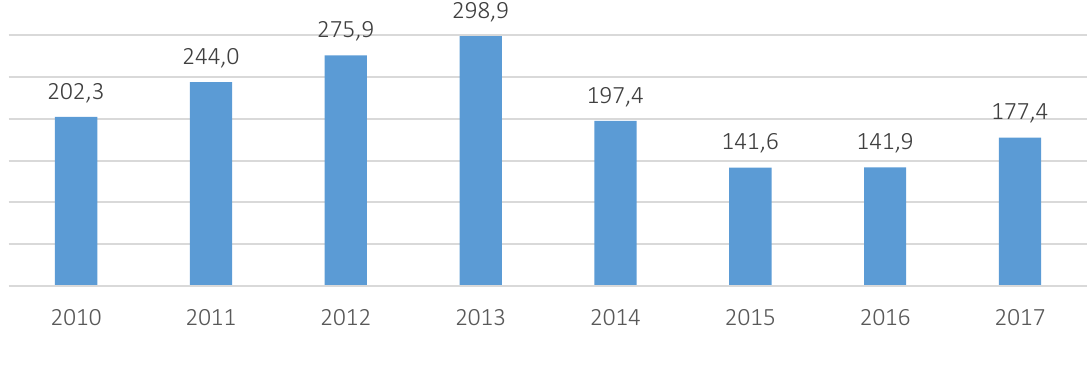
Figure 5. Current health expenditure per capita in USD, Ukraine, 2010–2017